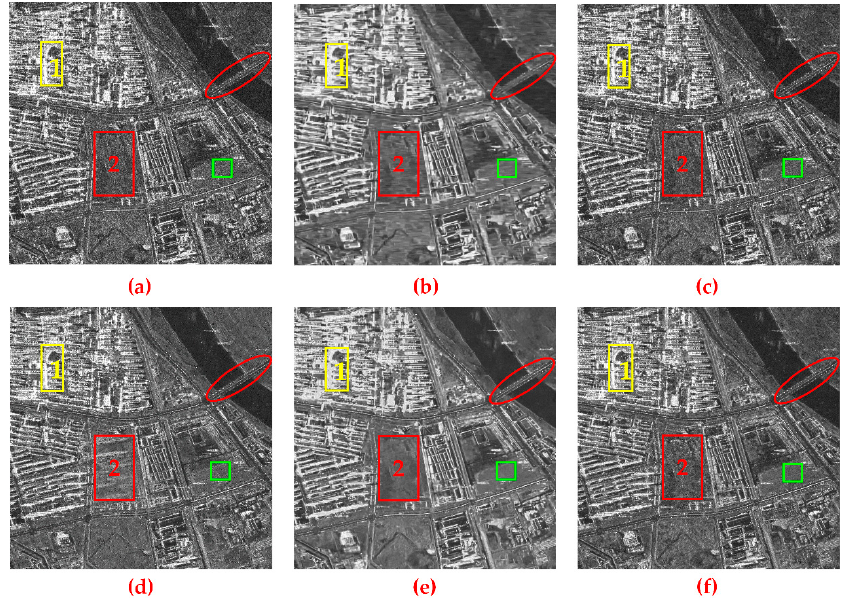
Figure 8. Filtering results for Dataset 1: ( a ) Original image (22 January 2012); ( b ) FANS; ( c ) QF; ( d ) CDMF; ( e ) MSAR_BM3D; ( f ) the proposed approach.